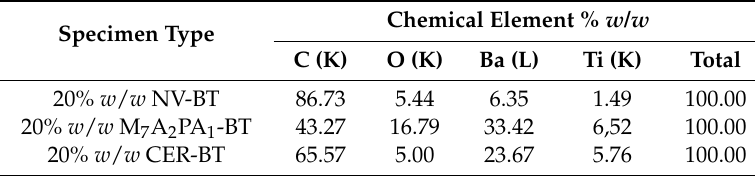
Figure 2. ( a ) Scanning Electron Microscopy (SEM) image of the specimen with commercial epoxy resin (CER) polymer matrix and 20% w / w BaTiO 3 , at a magnification of 800 times ( × 800) (subfigure: Scanning Electron Microscopy (SEM) image of the specimen with a novolac resin (NV) polymer matrix and 20% w / w BaTiO 3 , at a magnification of 800 times ( × 800)). ( b ) Energy Dispersive X-Ray Spectroscopy (EDAX) measurement for the 20% w / w BaTiO 3 specimen, with a CER polymer matrix, and ( c ) an Energy Dispersive X-Ray Spectroscopy (EDAX) measurement for the 20% w / w BaTiO 3 specimen, with an NV polymer matrix. Table 4. X-ray spectroscopy measurements from the three selected specimens in Figures 1,2.